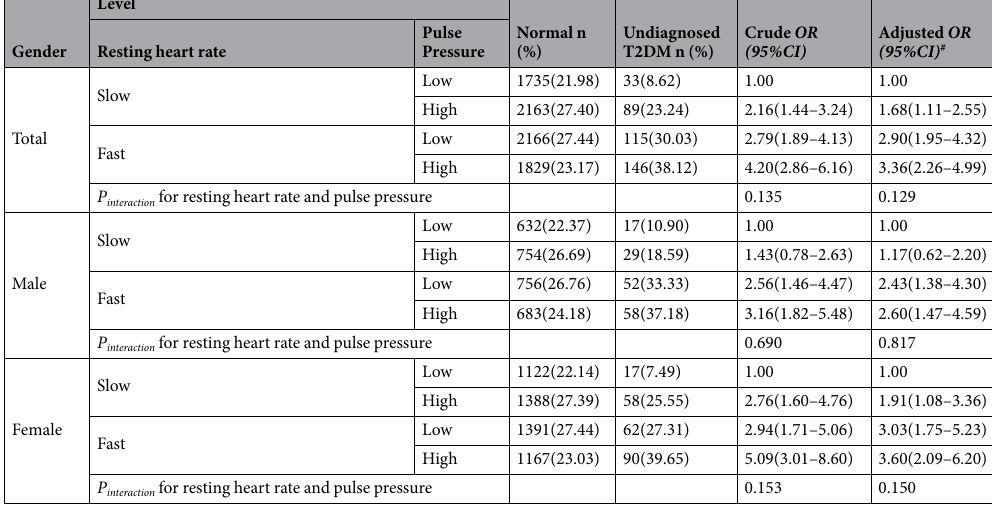
RHR and PP are simple indicators of autonomic nervous system function. Elevated RHR and/or PP might reflect the disorder of autonomic nervous system leading to the activation of the sympathetic nervous system 6 . Sympathetic over-activity is in connection with obesity, reduced insulin sensitivity, inflammation and the meta- bolic syndrome 35–38 , all of which could increase the risk of T2DM. Therefore, chronic sympathetic over-activity